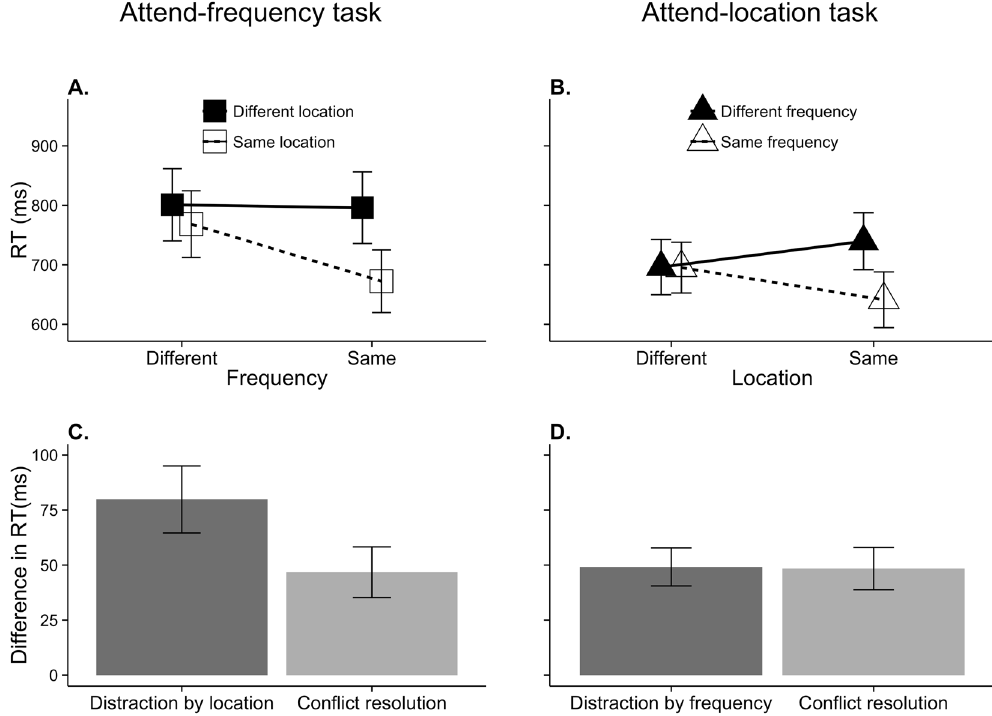
Figure 1. Group mean response times for the ( A ) attend-frequency and ( B ) attend-location TAiL tasks. Group mean measures of distraction and conflict resolution for the ( C ) attend-frequency and ( D ) attend-location TAiL tasks. The error bars represent the standard error of the mean.